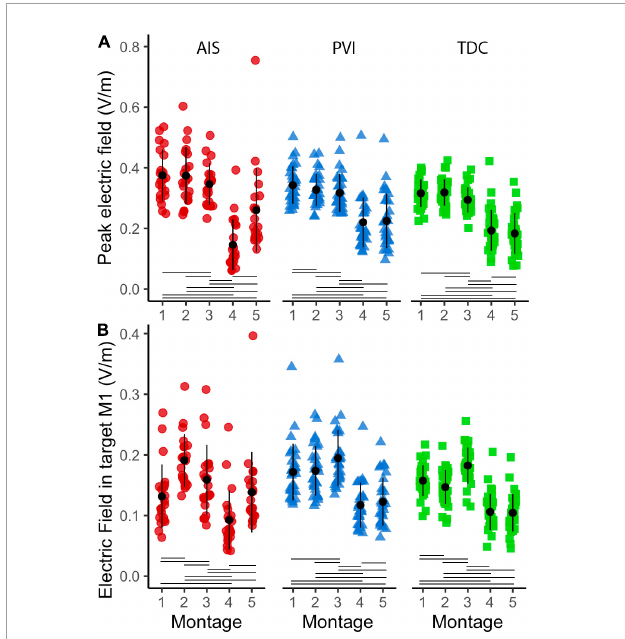
FIGURE6 Peak electric field (EF) strength and mean EF in target ROI gray matter (GM) in five montages by participant group (A) . Peak EF in GM differed across montages as did mean electric field in target M1 ROIs (B) . For montages 1, 3, and 4, lesioned M1 was the target, for montages 3 and 5 non-lesioned M1 was the target. ROI, region of interest; AIS, arterial ischemic stroke (red circles); PVI, periventricular venous infarction (blue triangles); TDC, typically developing control (green squares); M1, primary motor cortex. Horizontal lines denote significant pairwise contrasts ( p FDR < 0.01), vertical lines denote ± 1 standard